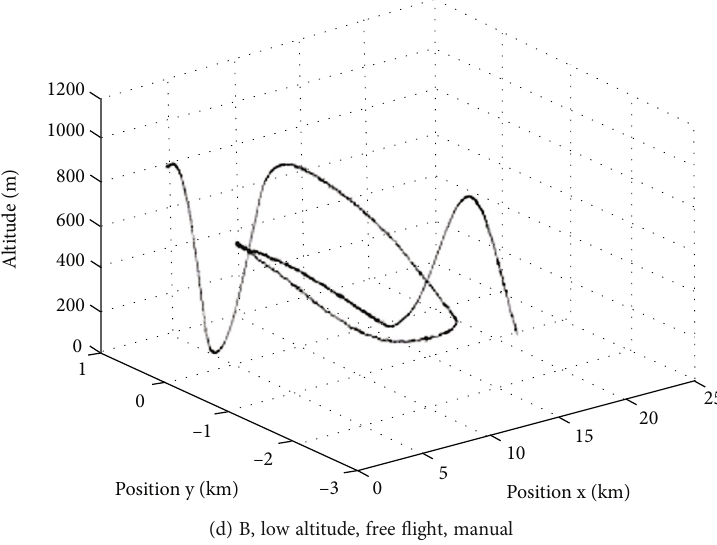
Figure 1: Flight trajectories of the 4 con fi gurations in Table 1.